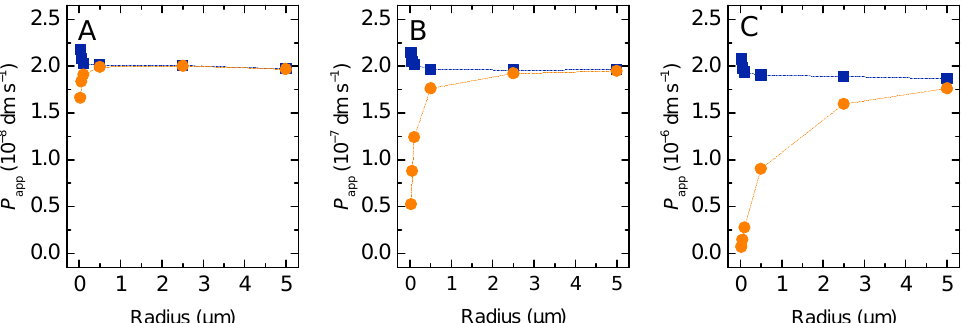
Figure 11. Effect of vesicle size and solute lipophilicity on the permeability coefficient calculated from the total amount of solute in the donor and acceptor compartments ( P app (cid:4) ) and from the solute in the aqueous compartments only ( P w app • ), for K P = 1 ( A ), 10 ( B ) and 100 ( C ). The dotted lines are guides for the eye.